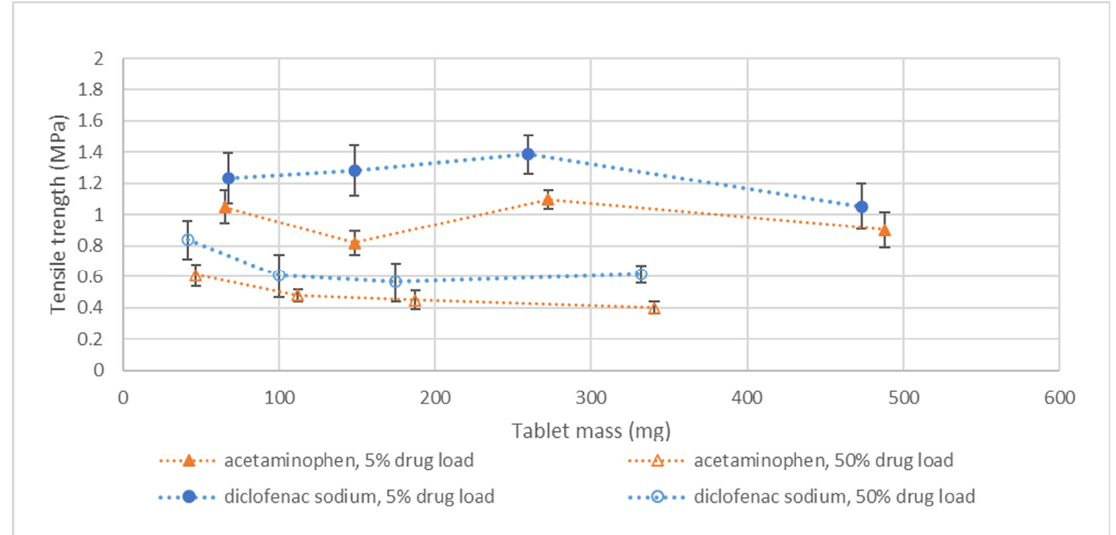
Figure 4. Tensile strength versus tablet mass for both the acetaminophen and diclofenac sodium formulations. Tablet mass was increased by printing the blend at a tablet diameter of 6, 9, and 12 mm. The 12 mm tablet was further increased in mass by increasing the number of layers from 7 to 13. Correlation between print dimensions and tablet mass can be found in Figure 3. The tablets were printed according to the formulations and print settings as provided in Table 4, meaning that the 50% w / w acetaminophen formulation contains 0.5% w / w silica and that the 50% w / w diclofenac so- dium formulation contains coarse API and were printed without outer line. The complete dataset of all drug loads can be found in the supplementary information, Figure S2.